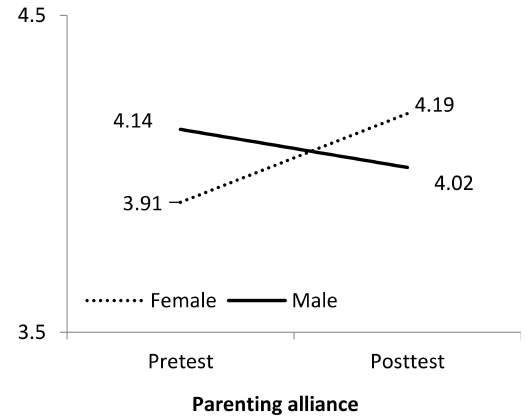
Figure 2. Interaction e ff ect of gender on parenting